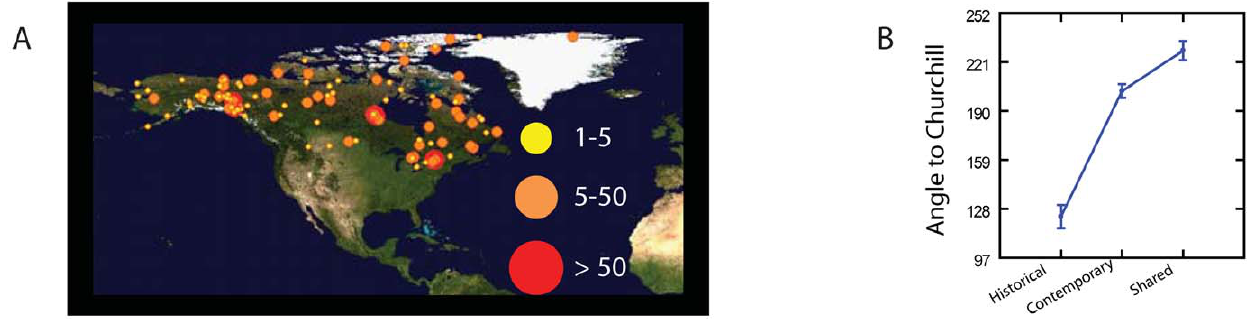
Figure 4. Broad collection localities and barcode affiliations. A ) Map of collection localities where barcode comparisons suggested faunal affiliations to Churchill (contemporary and historical). B ) Mean and SE of directions of that faunal affiliation to Churchill.